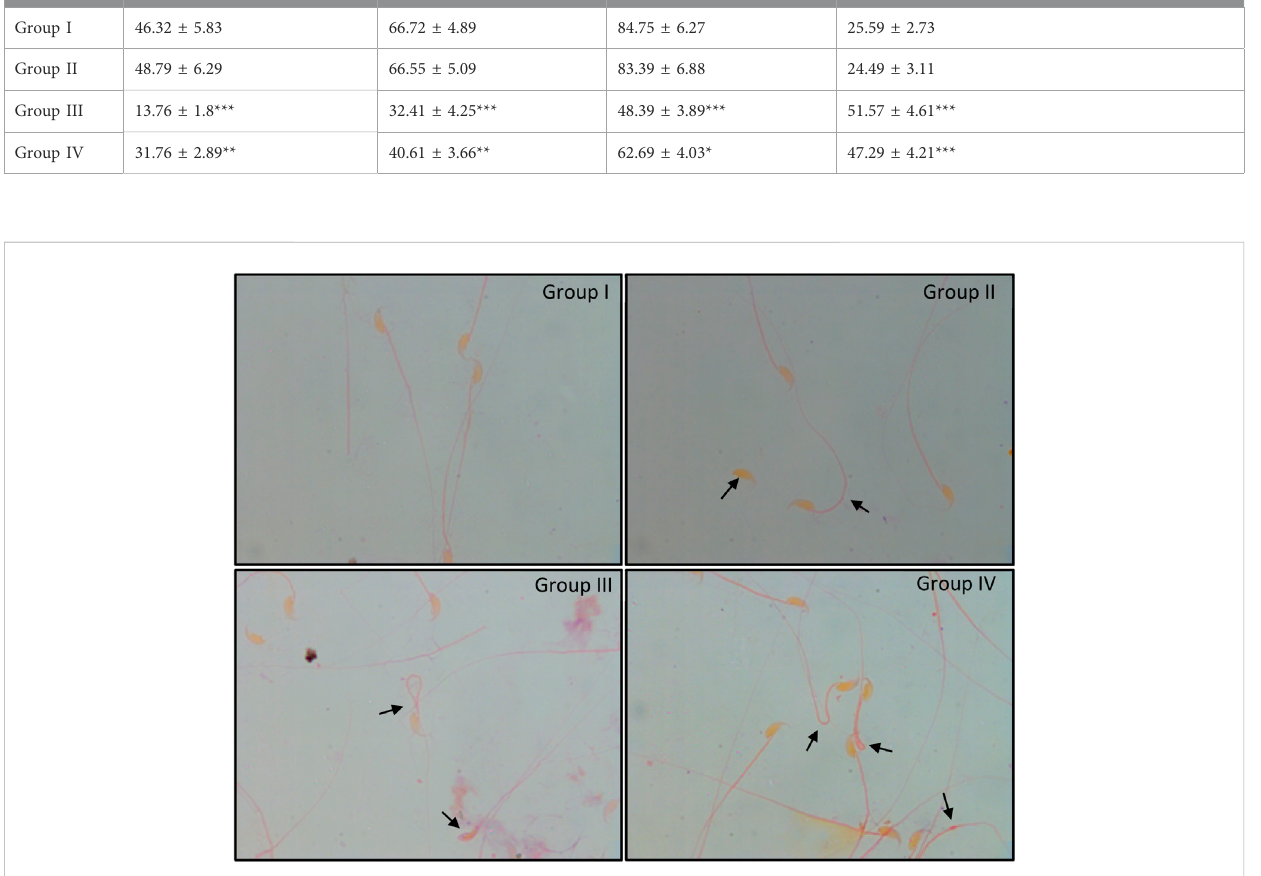
FIGURE 4 Papanicolaoustainingofcaudaepididymalspermexposedto6 Gygammairradiationpre-treatedwithorwithout C.borivilianum rootextract(CRE). Typical coiled and bent tail, head – tail separation, broken tail, hairpin tail, cytoplasmic droplet, and amorphous head are shown. Magni fi cation: